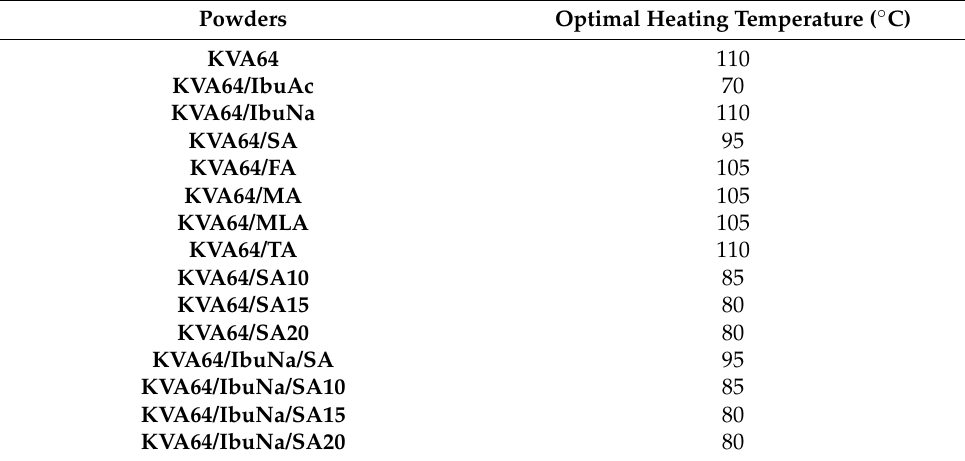
Table 2. Optimal heating temperatures for the different